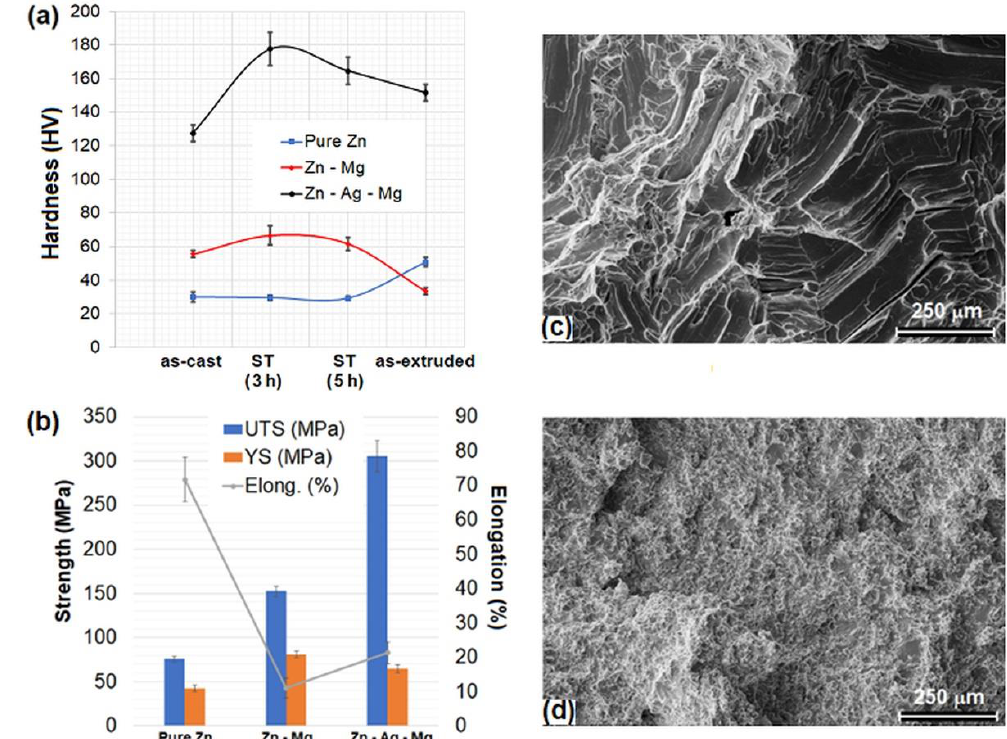
Figure 10. ( a ) Microhardness measurements (HV) of the investigated alloys; ( b ) tensile properties of the extruded alloys at room temperature; ( c , d ) SEM fractographies of the extruded alloys (Zn-1Mg and Zn-12.5Ag-1Mg, respectively).